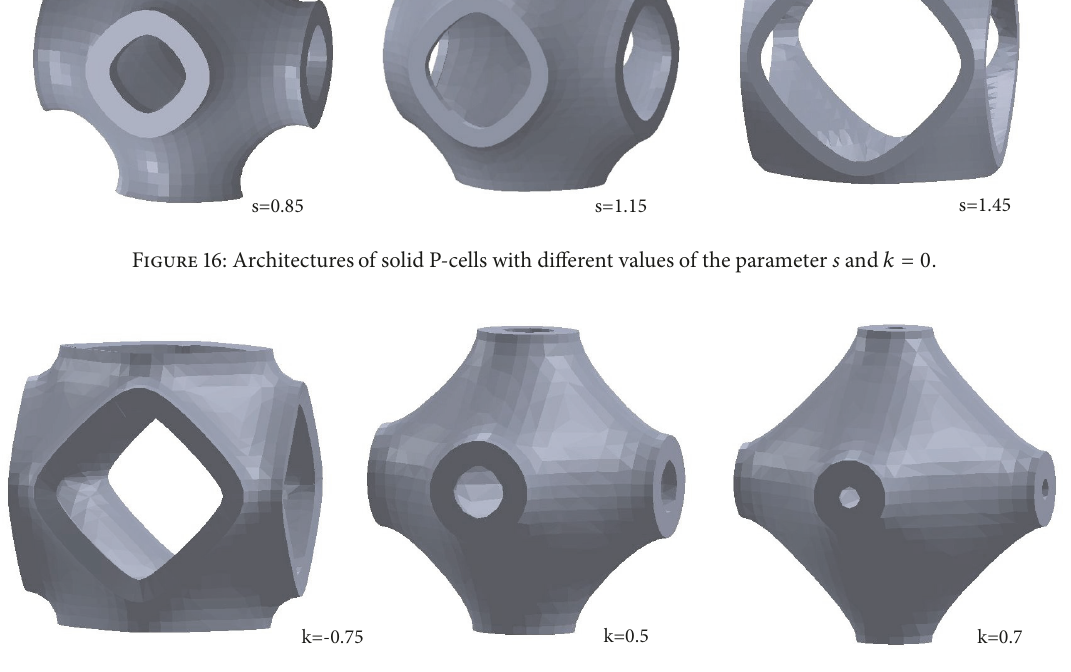
Figure 17: Architectures of solid P-cells with different values of the parameter 𝑘 and 𝑠 = 1 .